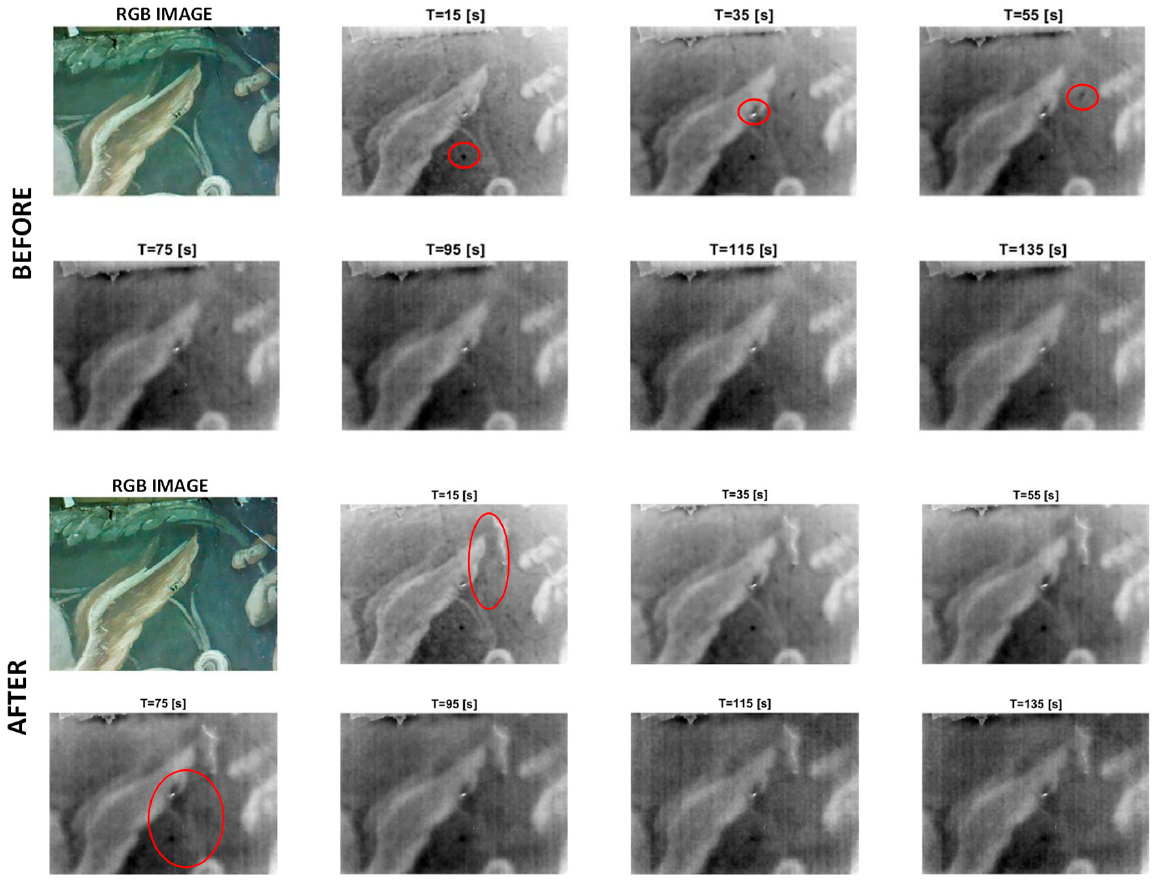
Figure 17. Sequence of emissivity images at different times obtained through PuCT before and after Ledan injection.